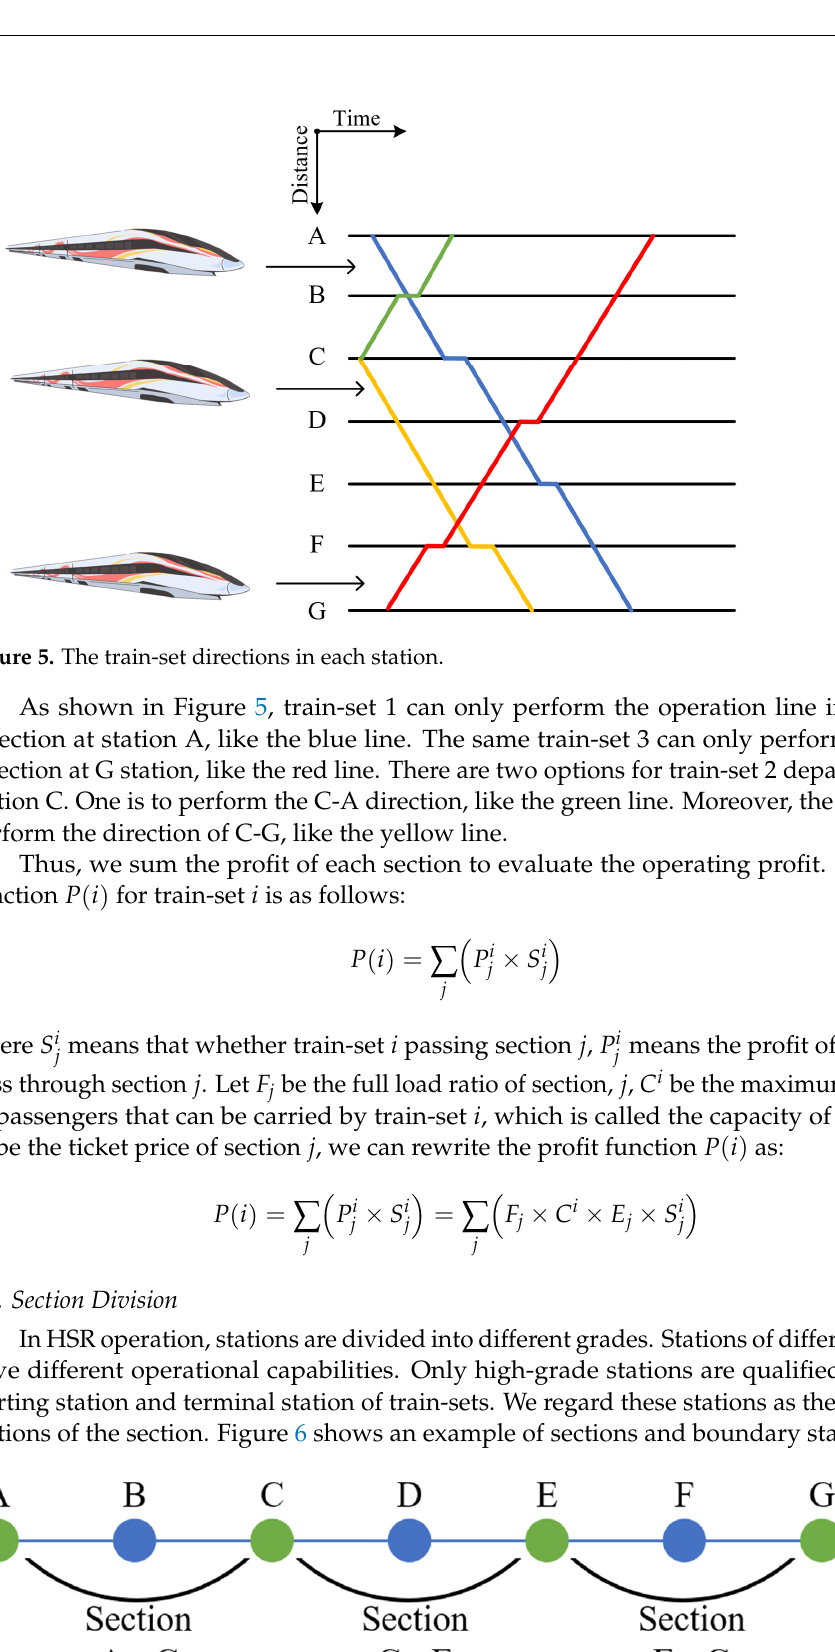
Figure 5. The train-set directions in each station.